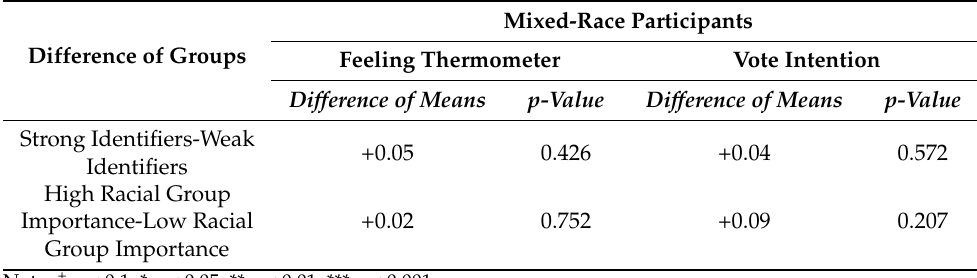
Table A8. Results from difference-of-means t -tests between high racial group identifiers and weak identifiers. Includes only mixed-race participants. Results indicate that those who strongly identify with their racial group and those who believe that their racial group is important to them are more likely to support the biracial-identified candidates, though these results are not statistically